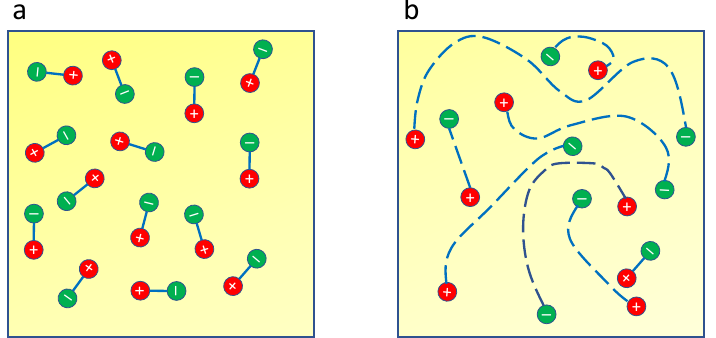
Figure 2. Magnetic monopole states at low temperatures. ( a ) Monopoles are confined into small dipoles by the tension of vortices connecting them. ( b ) As the tension vanishes, vortices become loose and magnetic monopoles at their endpoints